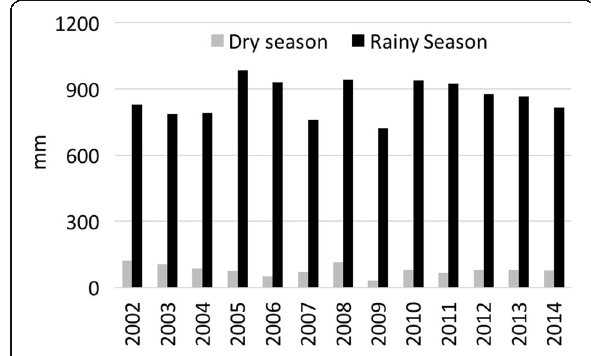
Fig. 2 Averaged rainfall in JJA and DJF in northern Vietnam